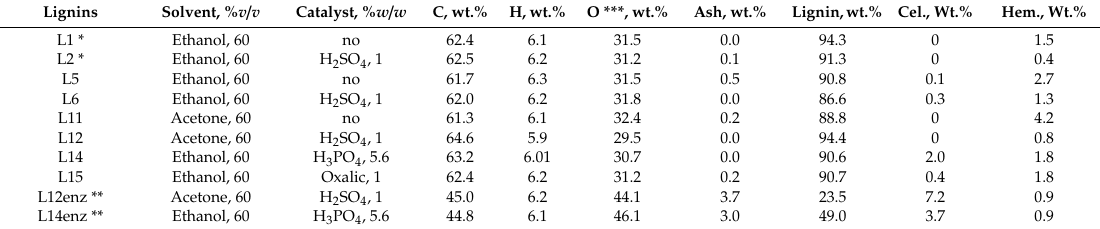
Ethanol, 60 Oxalic,